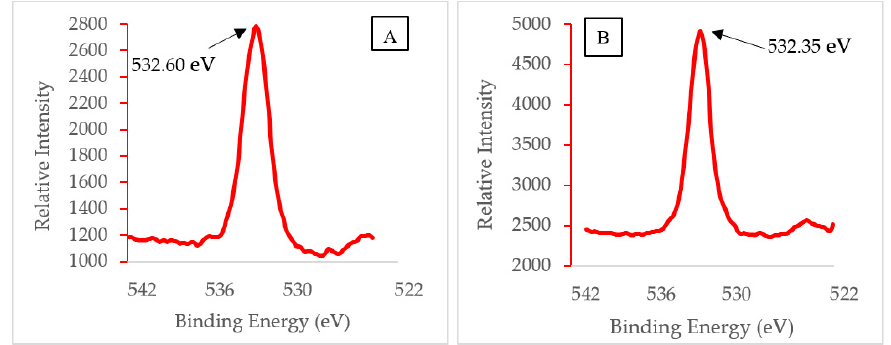
Figure 5. XPS oxygen (1s) spectrum of membranes ( A ) without UV exposure and ( B ) with UV